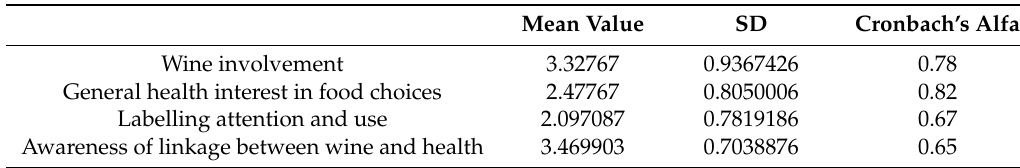
Table A1. Internal Consistency of Scale